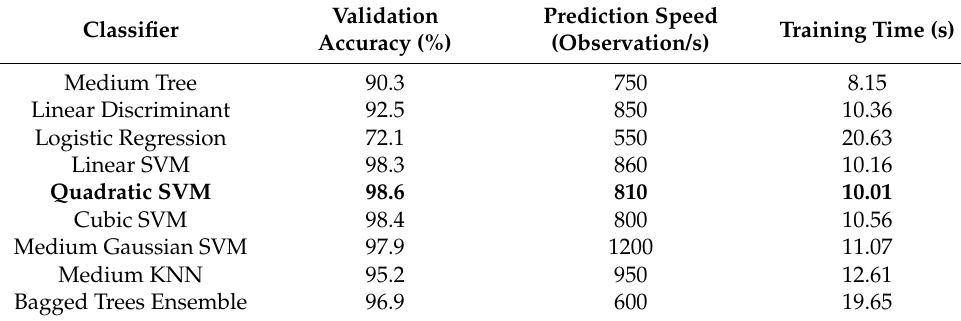
Table 4. Comparison of different classifiers using BOVW